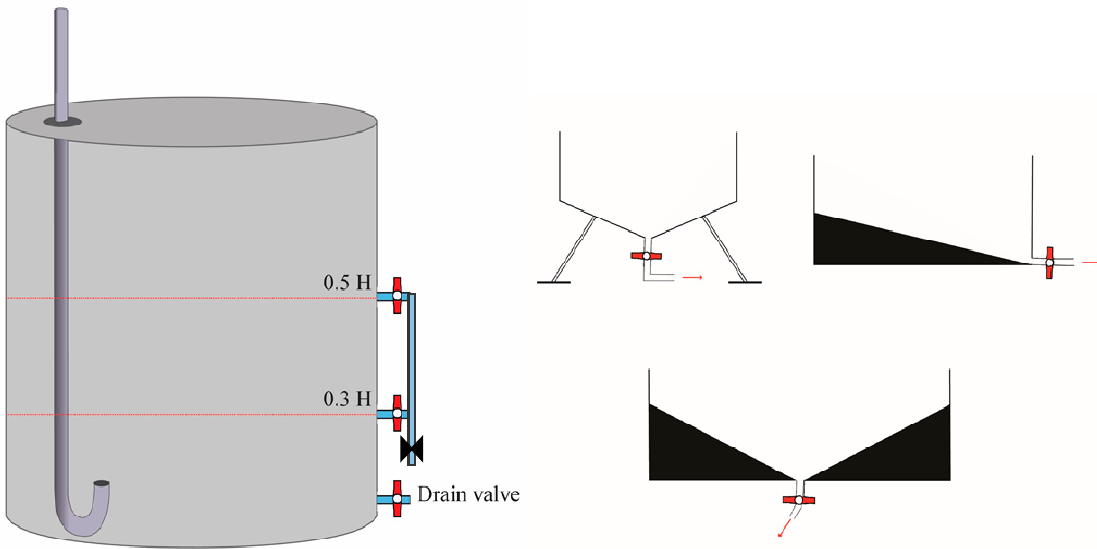
Figure 8. Recommended inlet / outlet design for rainwater storage tanks ( left ) and drain valve design for improved bottom sediment removal ( right ).